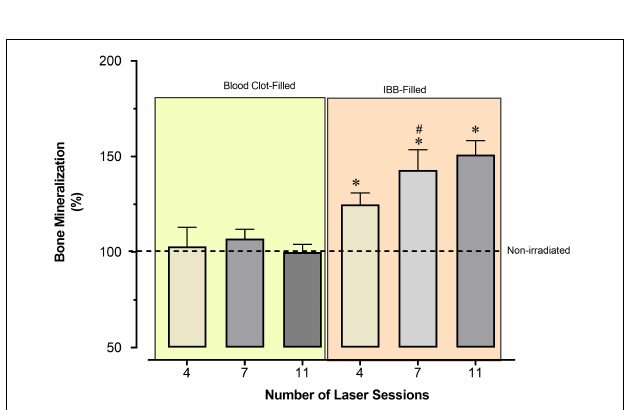
FIGURE 6 | Average percentage of bone mineralization caused by the type of cavity filling and the required number of sessions of LT, compared to the reference values observed in the Control group, expressed as 100% (horizontal dashed line). Values indicate the mean and the mean standard error. ∗ p < 0.05 vs. Control group; # p < 0.05 vs. the previous time-point of the same group. Statistical analysis: two-way ANOVA for N = 6 rats per group.